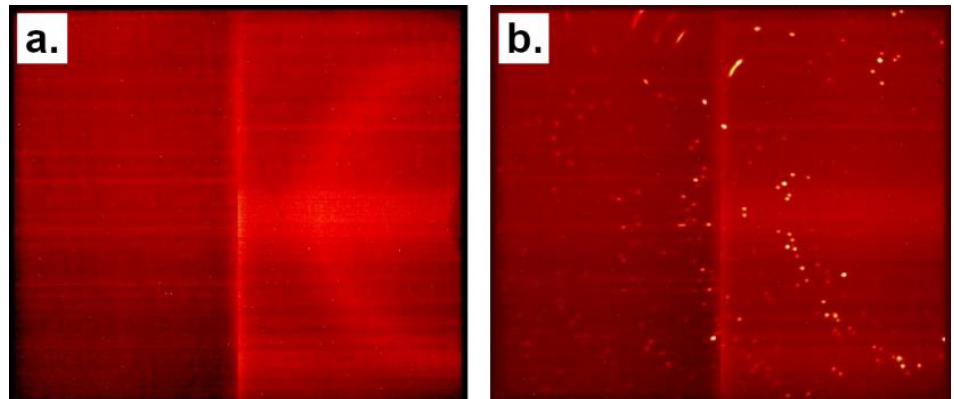
Figure 7. ( a,b ) Focused X-ray beam 360° φ rotation diffraction experiment on 100 μm fragments of betafite ( a ) and apatite ( b ). Note the absence of discrete diffraction spots in the scan of betafite ( a ) compared to the abundance of discrete spots observed in the scan of apatite ( b ).